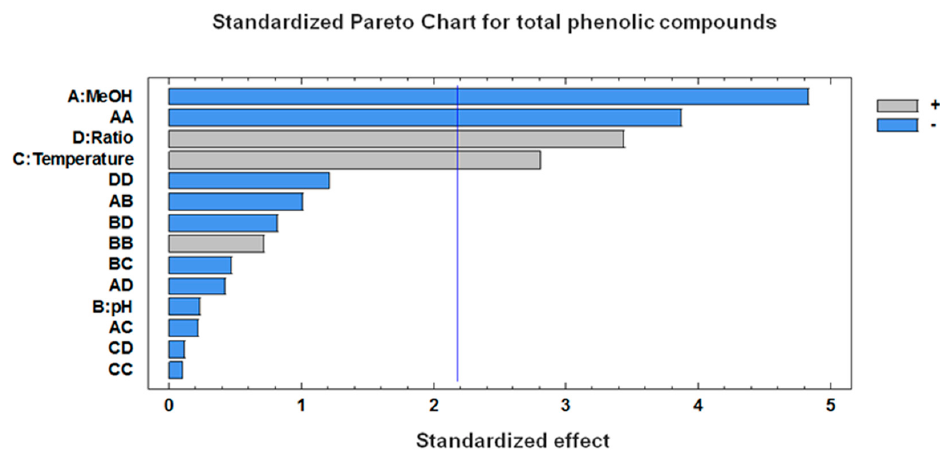
Figure 2. Pareto chart representing the standardized effects of the different variables on the MAE of the phenolic compounds in Santolina chamaecyparissus L.